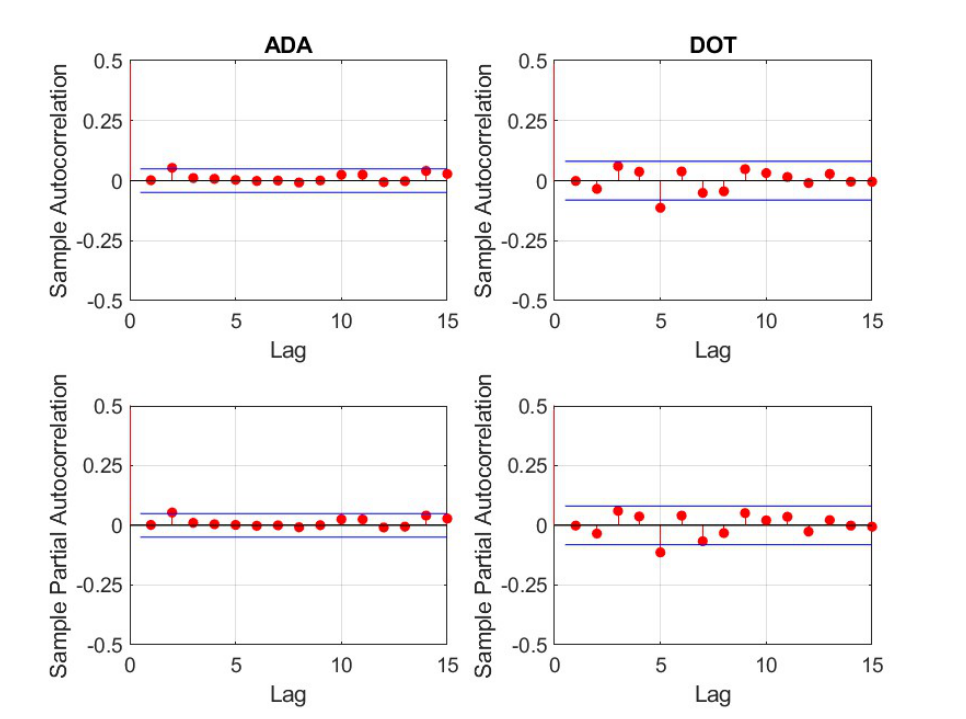
Figure A11. ADA’s and DOT’s residuals’